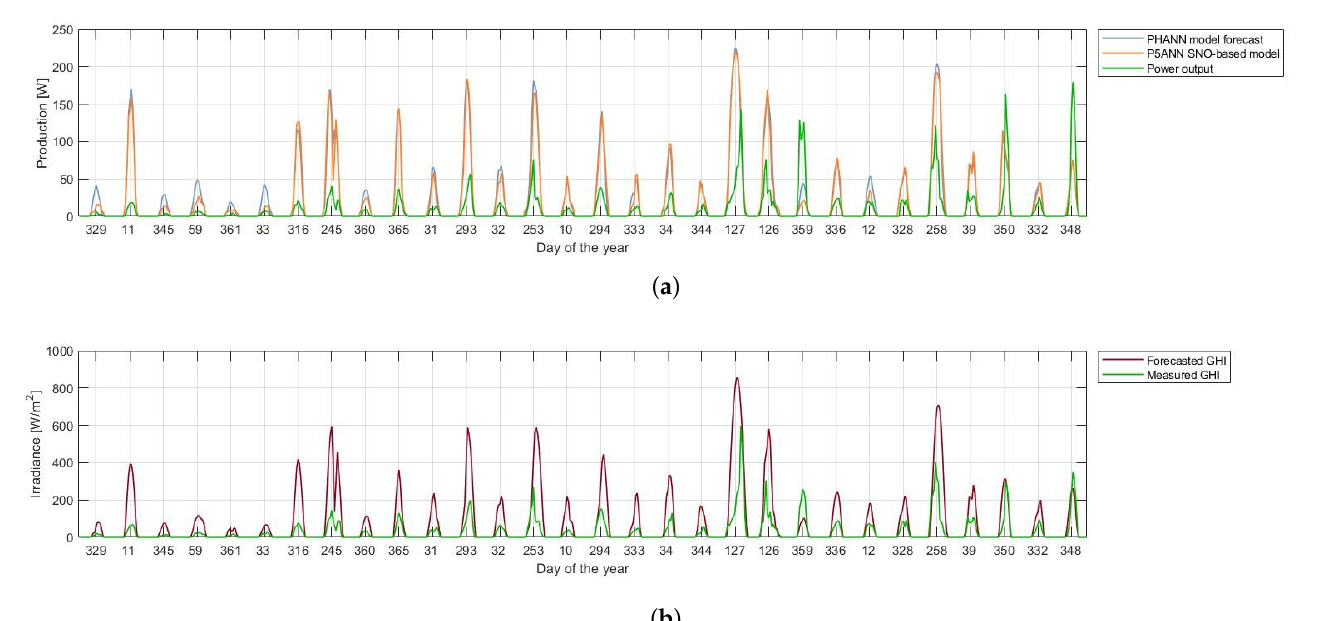
Figure 13. Comparison of the 30 worst days of the PHANN model between ( a ) the forecasted power of the PHANN and P5ANN SNO-based models, and ( b ) the forecasted and measured